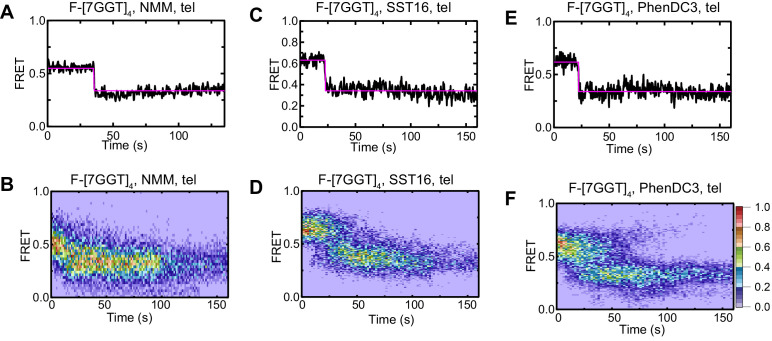
Effect of ligands on FRET of F-[7GGT]4 in the presence of telomerase.Representative FRET trajectories (A, C, E) and heat maps (B, D, F) of F-[7GGT]4 in the presence of NMM (10 mM in folding reaction), SST16 (100 µM) or PhenDC3 (1 µM), with telomerase; n = 80 (B), 60 (D), 74 (F) molecules, collected in 4–6 independent experiments. For color key, see panel (F).